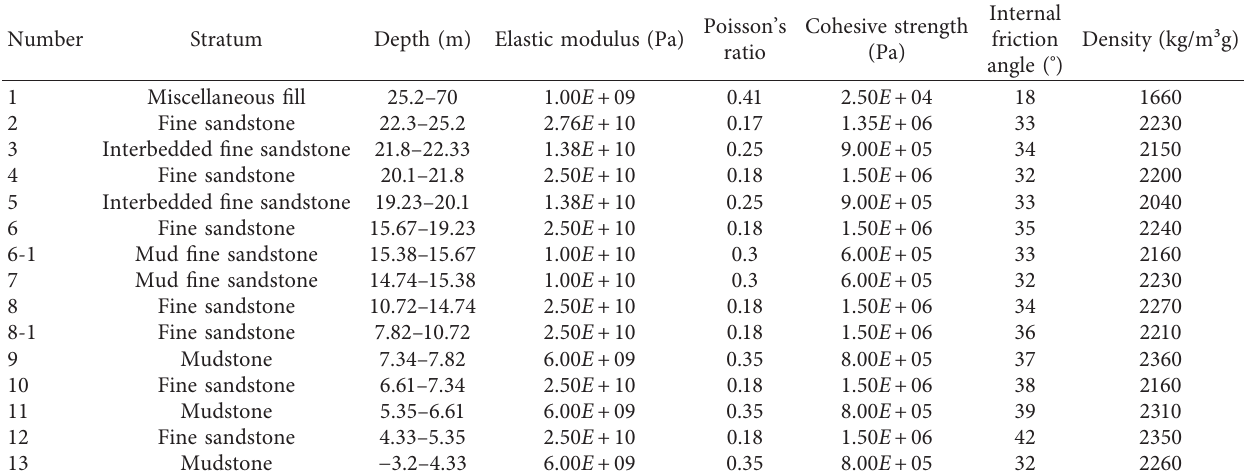
Figure 8: Distribution characteristics of main cracks in Yuanjue Table 1: Parameters of formation lithology.